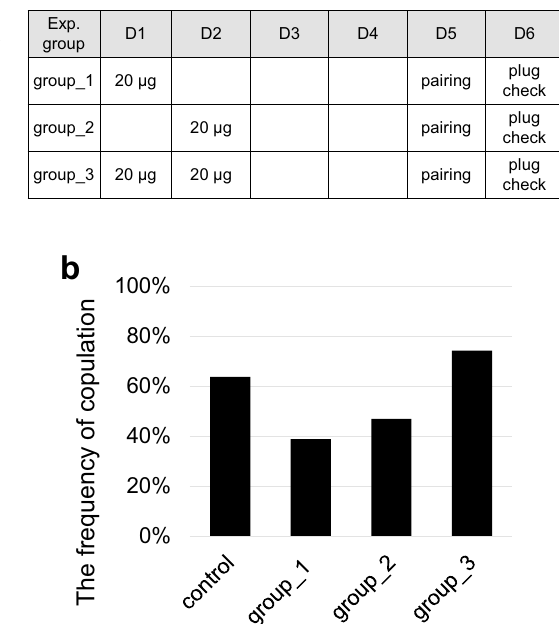
Figure 2. LHRHa dosage conditions and the frequency of copulation. ( a ) Scheme of LHRHa administration schedules and treated LHRHa concentrations. ( b ) Rate of the frequency of copulation with the male after LHRHa administration of female in Fig. 2a conditions. Control means the data using proestrus or estrus stage female mice by vaginal cytology. The actual measurement value was shown in Table 2 and Supplementary Table S1.